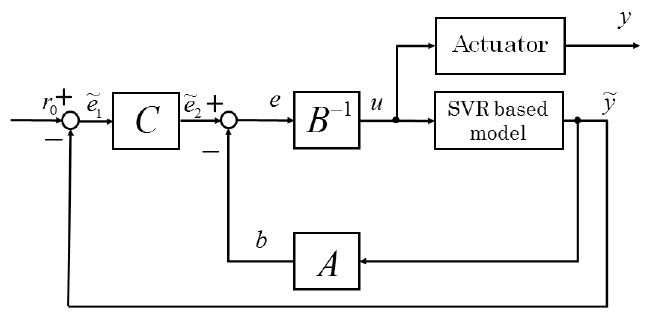
Figure 8. Control system with SVR